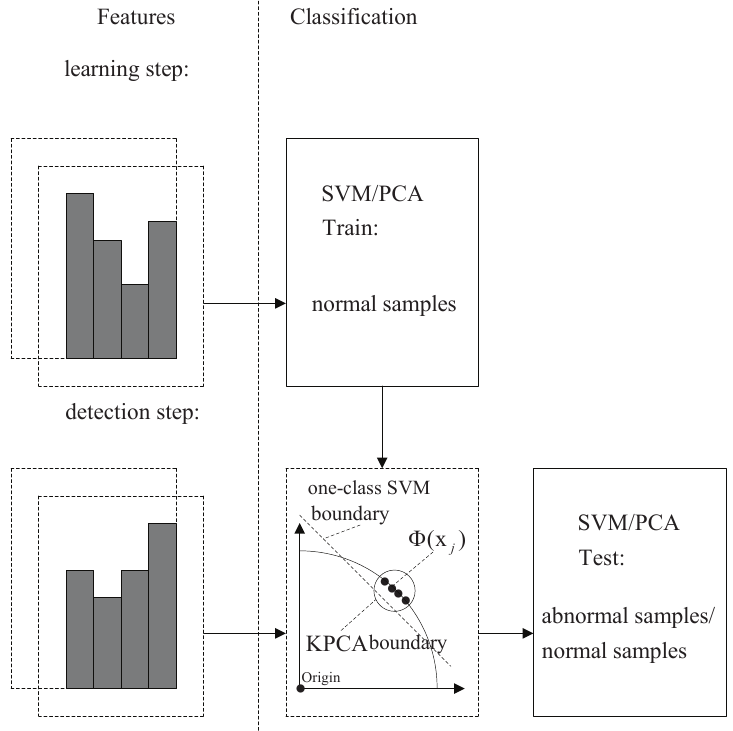
Figure 3. The flowchart of the proposed feature classification-based abnormal detection